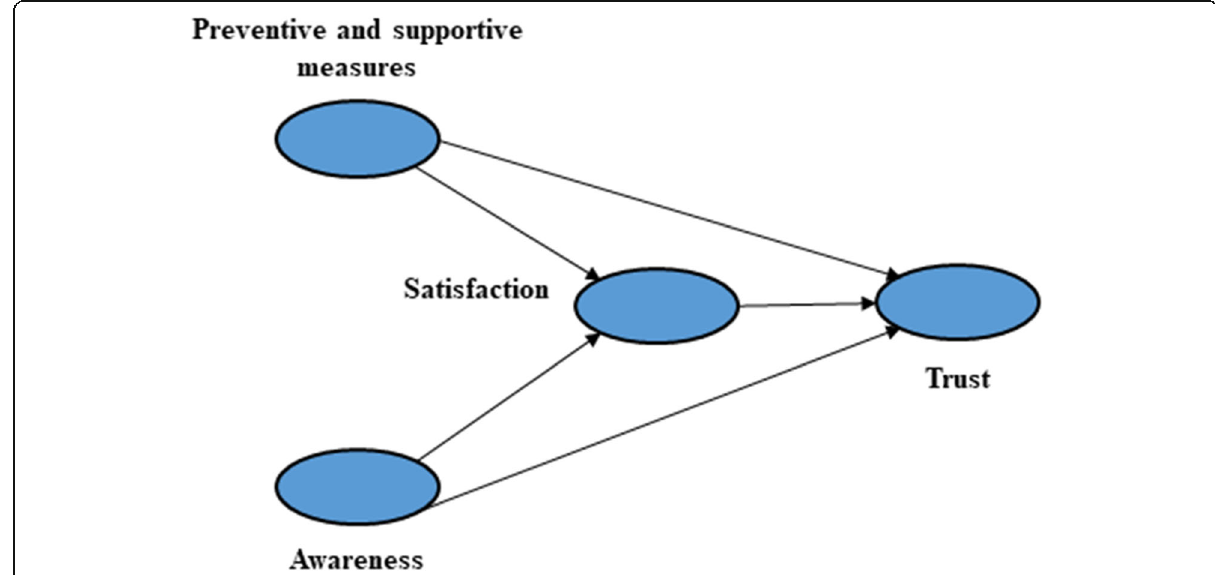
Fig. 1 The Conceptual model for